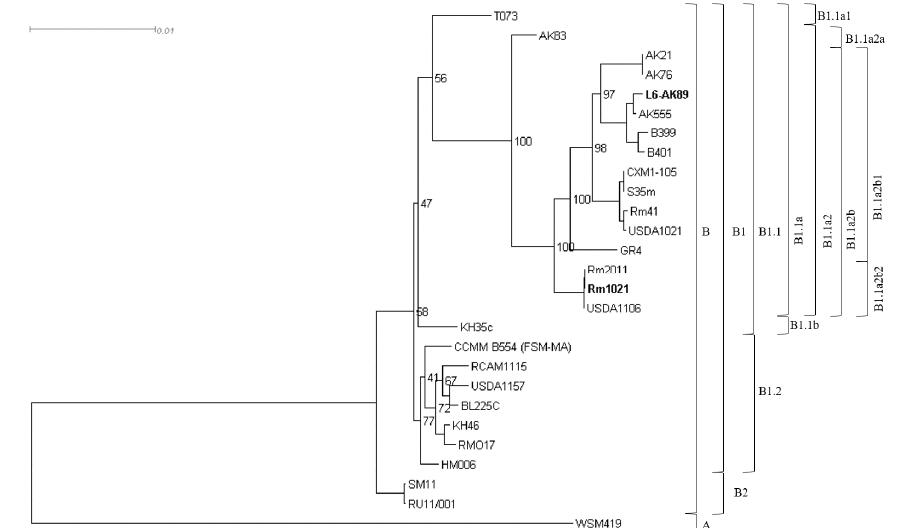
Figure 7. Phylogenetic analysis of 21 concatenated nod / noe / nol nucleotide sequences in Ensifer spp. Nucleotide substitution model selected for analysis was TN + F + I + G4. Scale bar = 0.01 for nod / noe / nol substitutions per site. Rooted tree was created by using maximum likelihood algorithm. Statistical support for internal nodes was determined by 1000 bootstrap